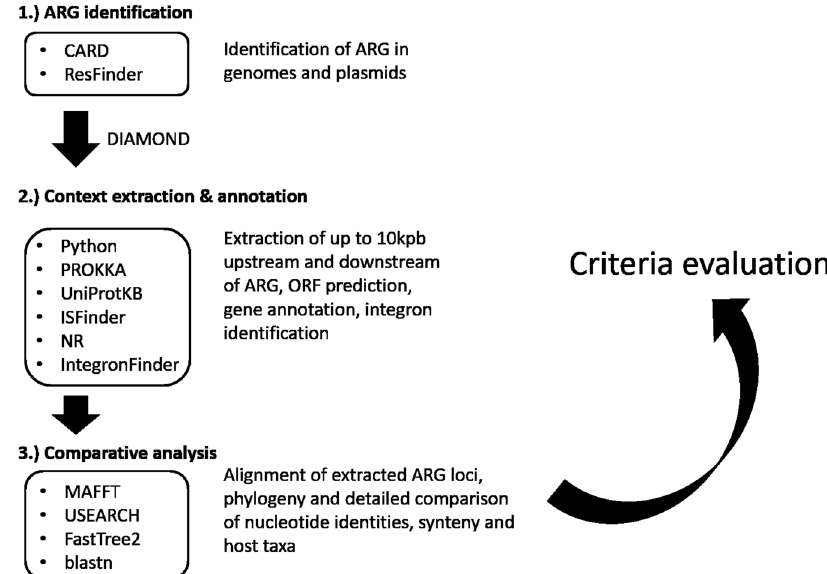
Fig. 1 Comparative genomics work fl ow. Work fl ow and tools/databases used for amendment and scrutinization of proposed origins of